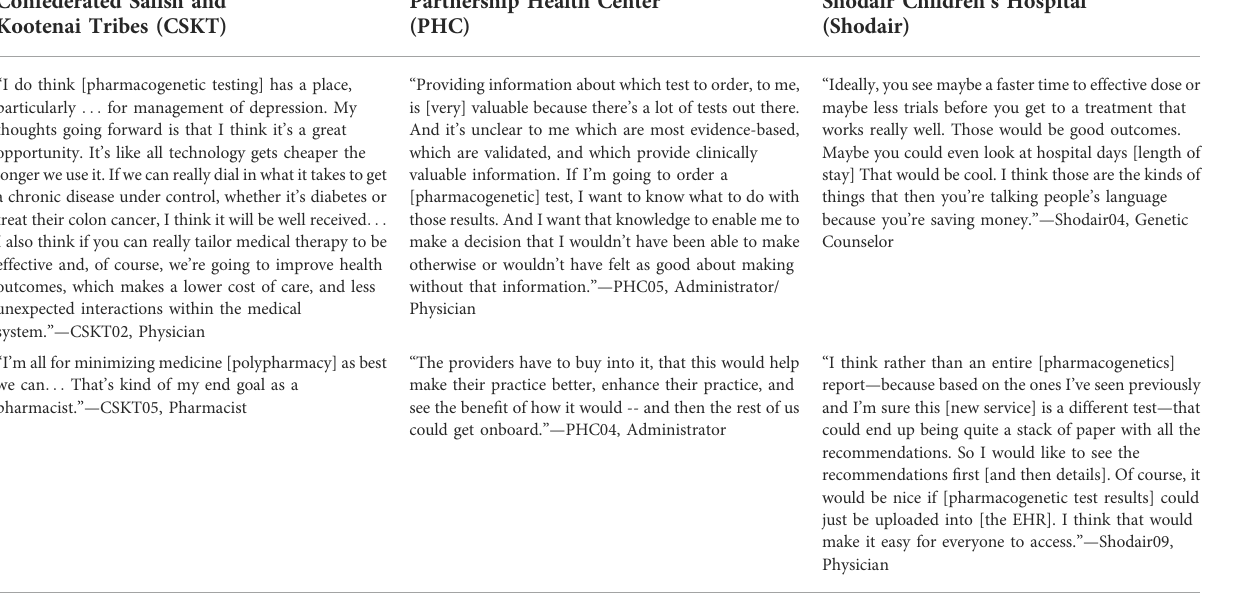
TABLE 5 Facilitators and perceived value of pharmacogenetic testing services targeted to underserved patient populations. Confederated Salish and Kootenai Tribes